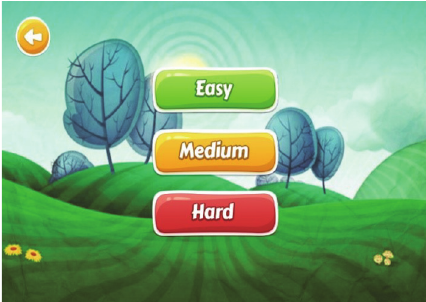
Figure 10: A screenshot of menu level page.